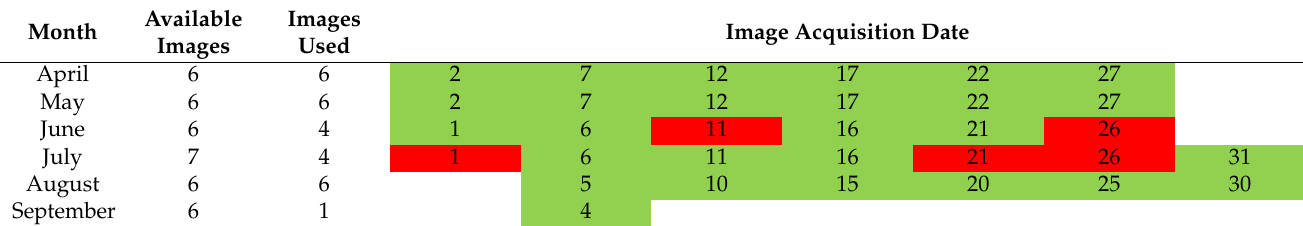
Table 3. Acquisition dates of the scenes included in the